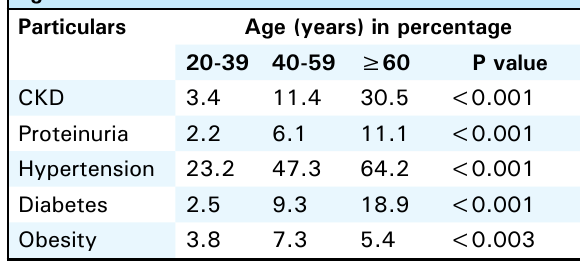
Table 2. Prevalence of CKD and its risk factors by age. Table 3. Multiple logistic regression model to predict CKD.